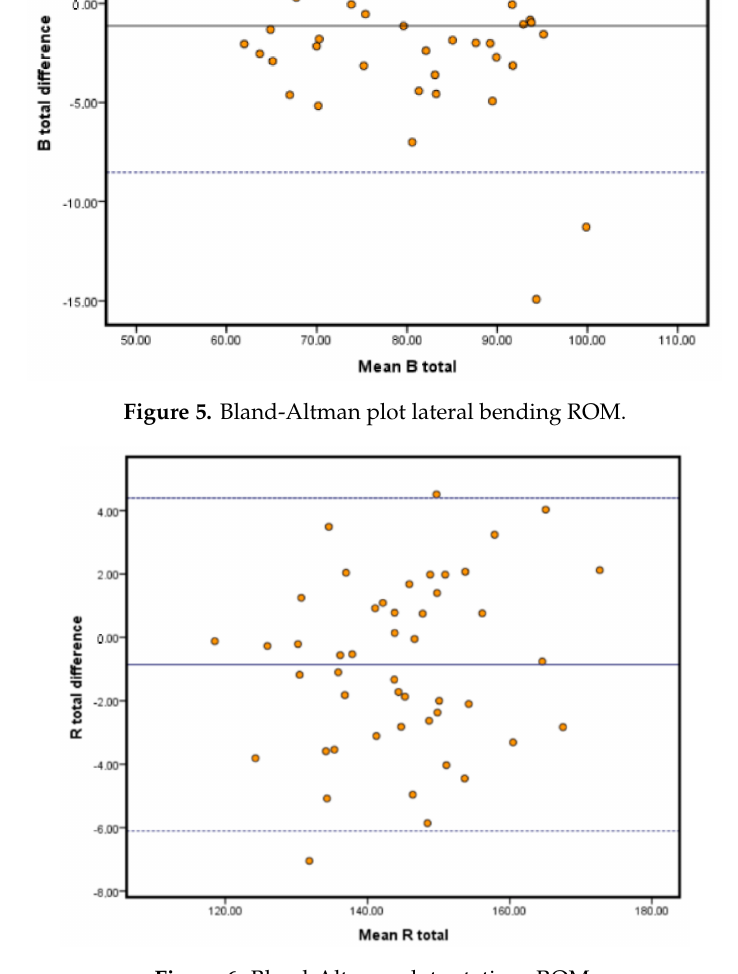
Figure 6. Bland-Altman plot rotations